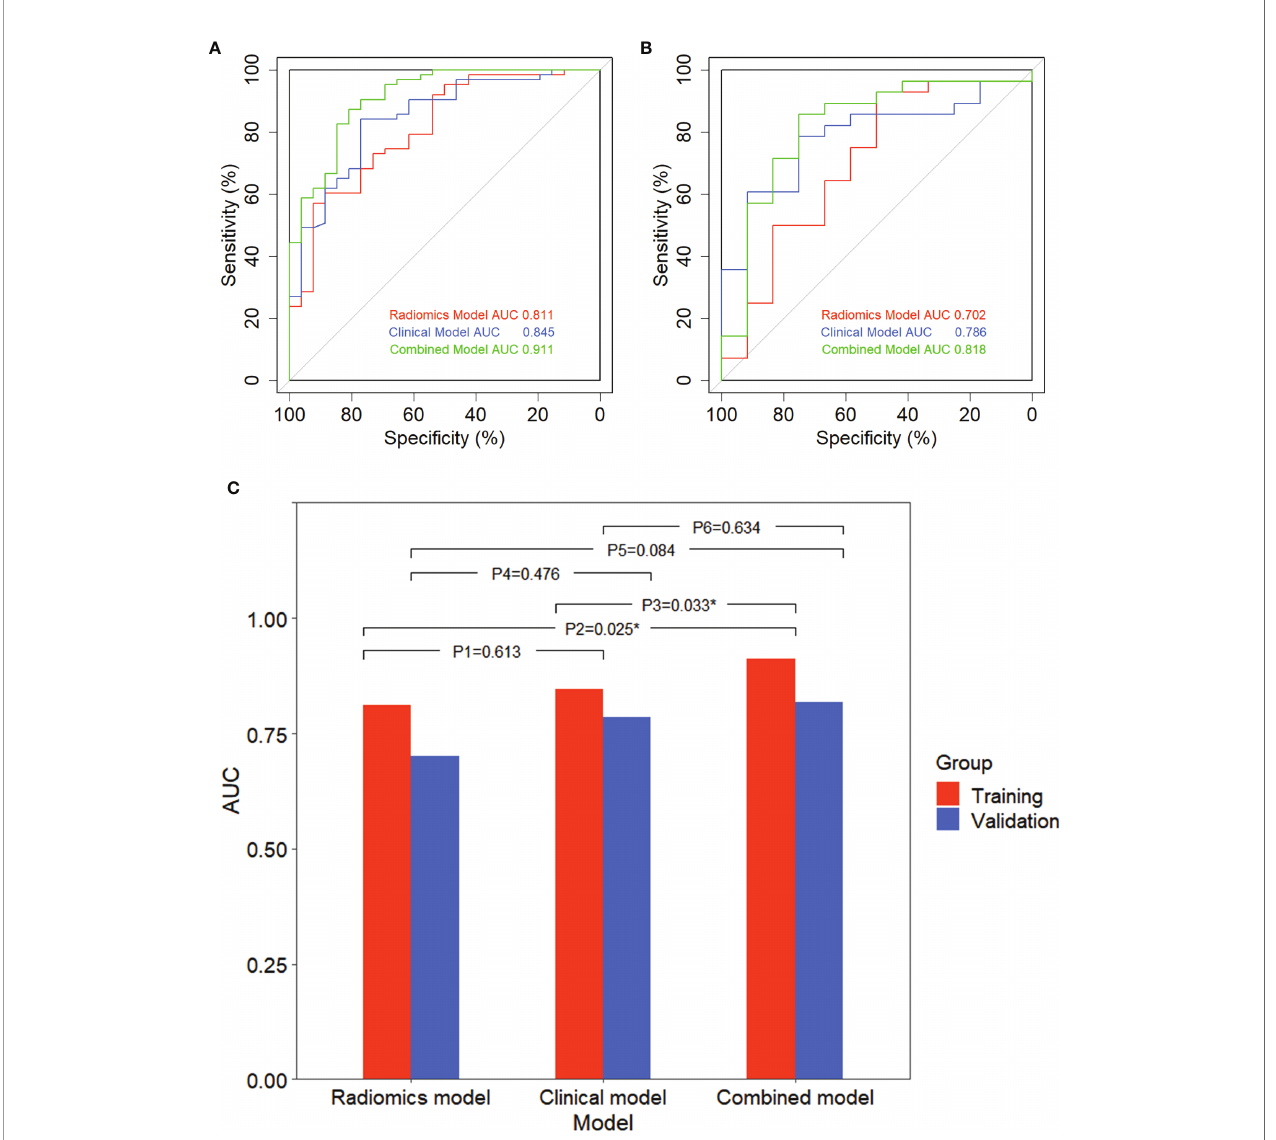
FIGURE 6 | Receiver operating characteristic (ROC) curve of three models and comparison of ROC curves. ROC curve of three models in the training group (A) and validation group (B) . (C) Comparison of ROC curves with DeLong test in the training group and validation group.P1, P2, and P3 are in the training group; P4, P5, and P6 are in the validation group; P1 and P4: radiomics model vs. clinical model; P2 and P4: radiomics model vs. combined model; P3 and P6: clinical model vs. combined model. * p < 0.05, expressive signi fi